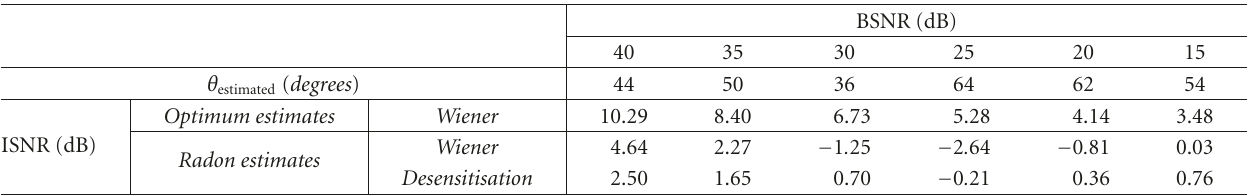
Table 2: Set of ISNR results obtained by both the Wiener filter and our proposed method when using estimates of a motion PSF (length of 15 pixels and inclination of 45 degrees) computed by the Radon transform in di ff erent Gaussian noise conditions (the noise variance is estimated with the actual value). The respective estimated values of θ estimated are showed, leaving the l estimated to the real value.